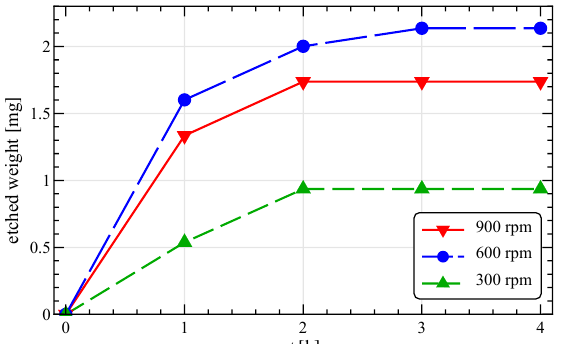
Figure 2. Experimental time evolution of the total etched material from the Ag beads at different stirring velocities. The initial total mass of the four Ag beads is about 593mg.